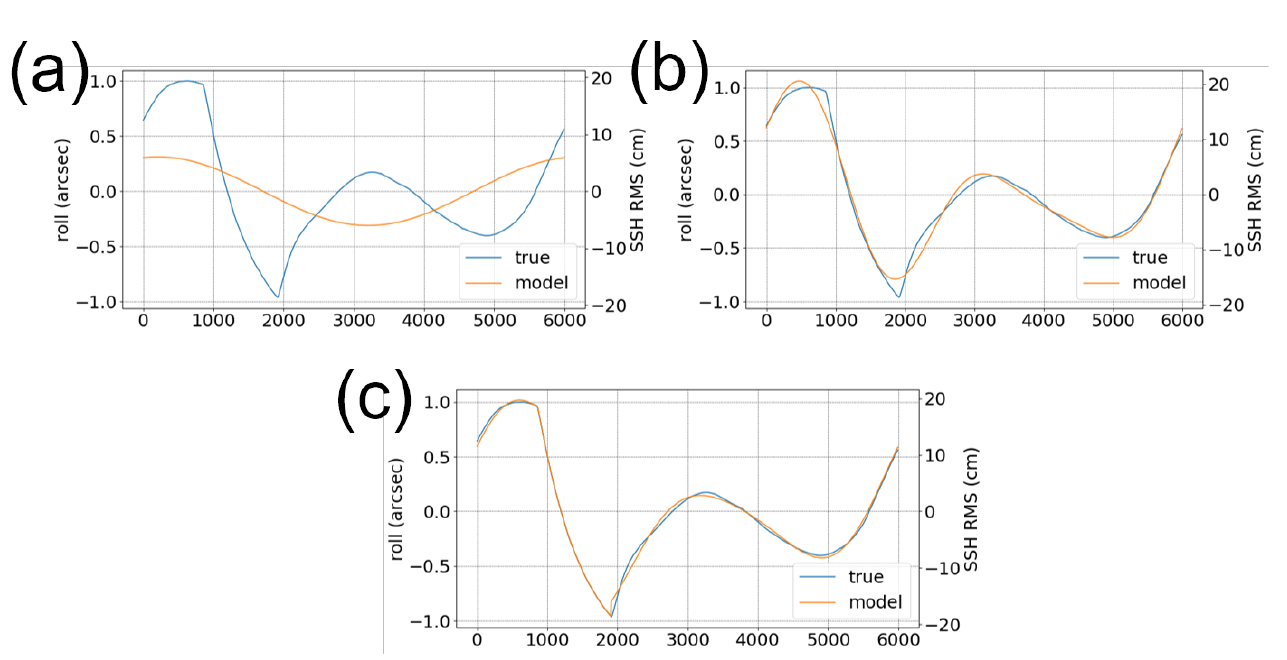
Figure 20. Simulation of a calibration on the thermoelastical distortion from Sentinel-3 Next Generation phase A studies. The blue curve is the uncalibrated roll error in arcsec (and cm RMS), and the orange curve is our calibration retrieval. Panel ( a ) is for the pre-launch algorithm of SWOT (1 harmonic). Panel ( b ) is when more orbital harmonics are added (3 harmonics). Panel ( c ) is when the orbital harmonics are estimated separately on the illuminated and eclipse segments of the orbit (2 × 3 harmonics).